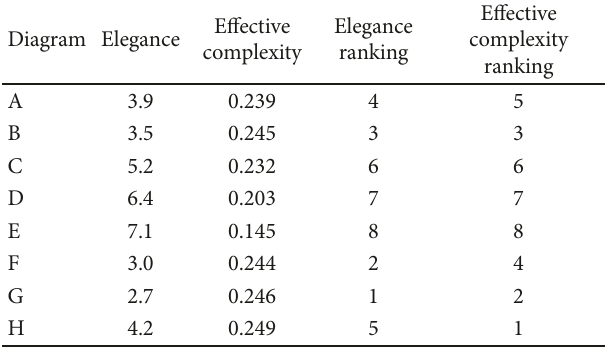
Table 8: Data for Spearman correlation coe ffi cient calculation.